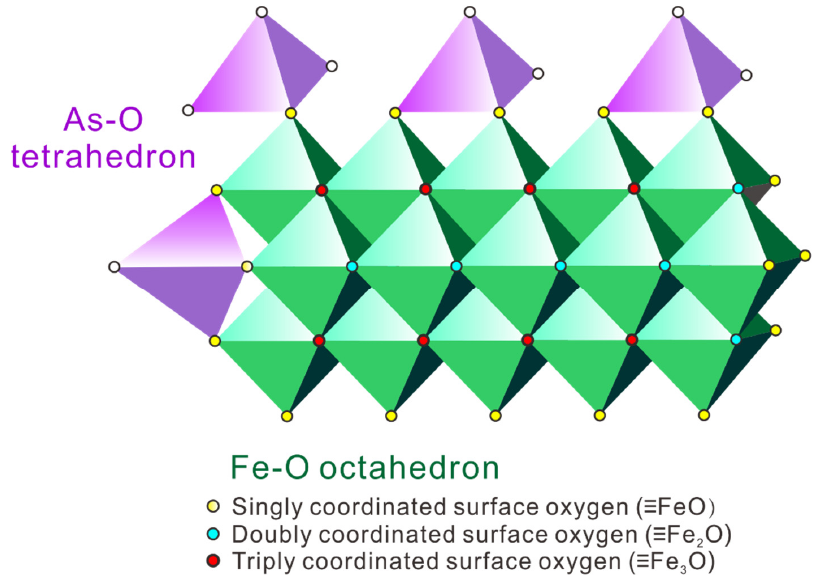
Figure 12. Charge on singly, doubly, and triply coordinated ‐ surface hydroxyl ‐ functional groups, in octahedrally coordinated iron oxide.